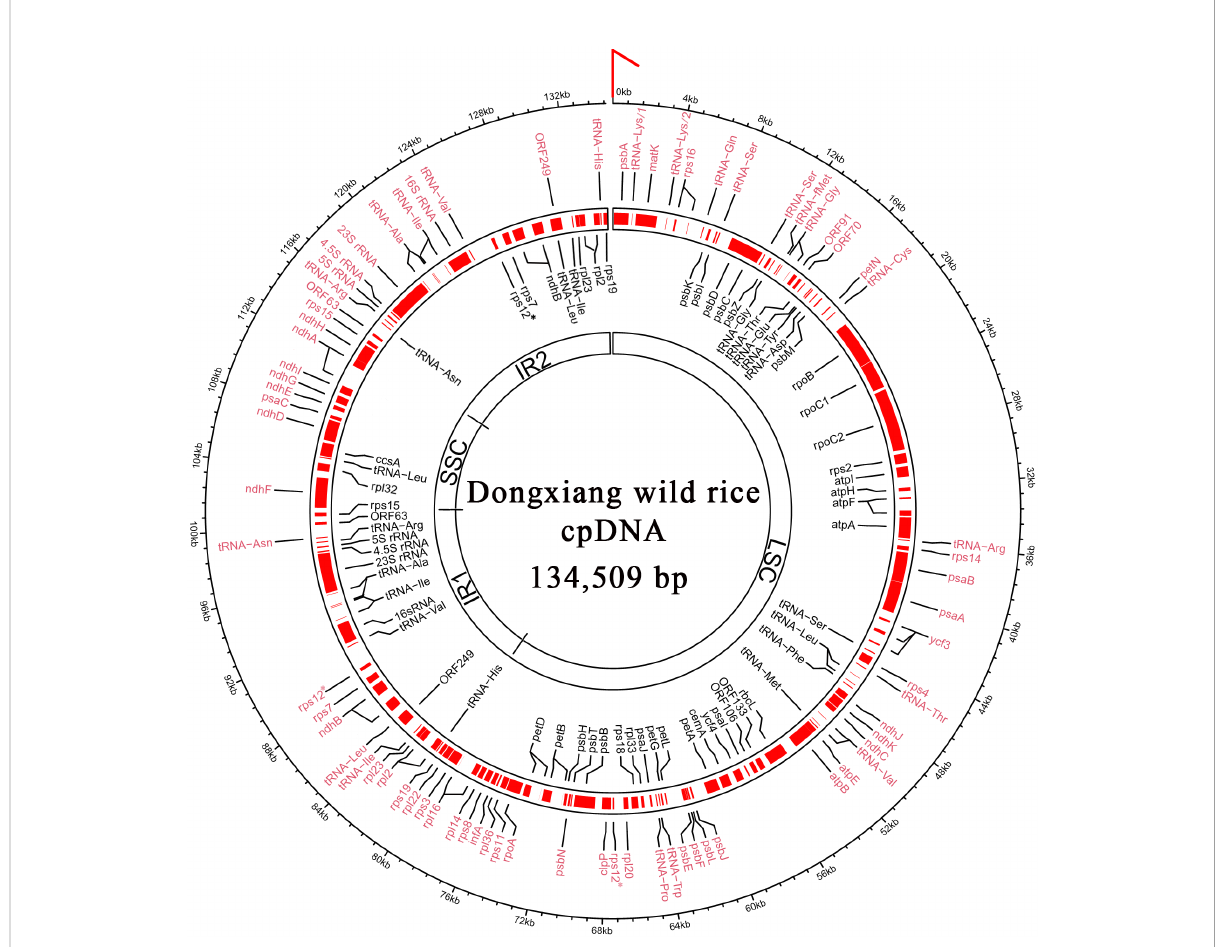
FIGURE 1 Full-length chloroplast genome of Dongxiang wild rice. According to the structure LSC-IR1-SSC-IR2, the genome sequence of circular cpDNA was clockwise linearized, starting at the fi rst three nts “ CCC ” of LSC (indicated by a red arrow). In total, 4 rRNA, 30 tRNA, 76 protein-coding genes and 6 ORFs are annotated. The genes encoded on the forward strand and reverse strands are indicated by symbols written in black and red text, respectively. The genome sequences and the gene annotations are provided in the supplementary fi le 1 and 2, respectively. LSC, large single-copy region; SSC, small single-copy region; IR1, inverted repeat 1; IR2, inverted repeat 2. * The gene rps12 has two exons and the second exon has two copies in IR1 and